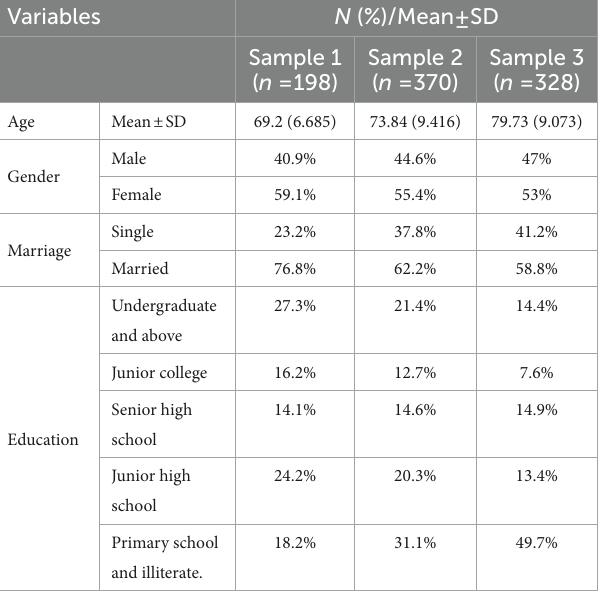
TABLE 2 Demographic characteristics of